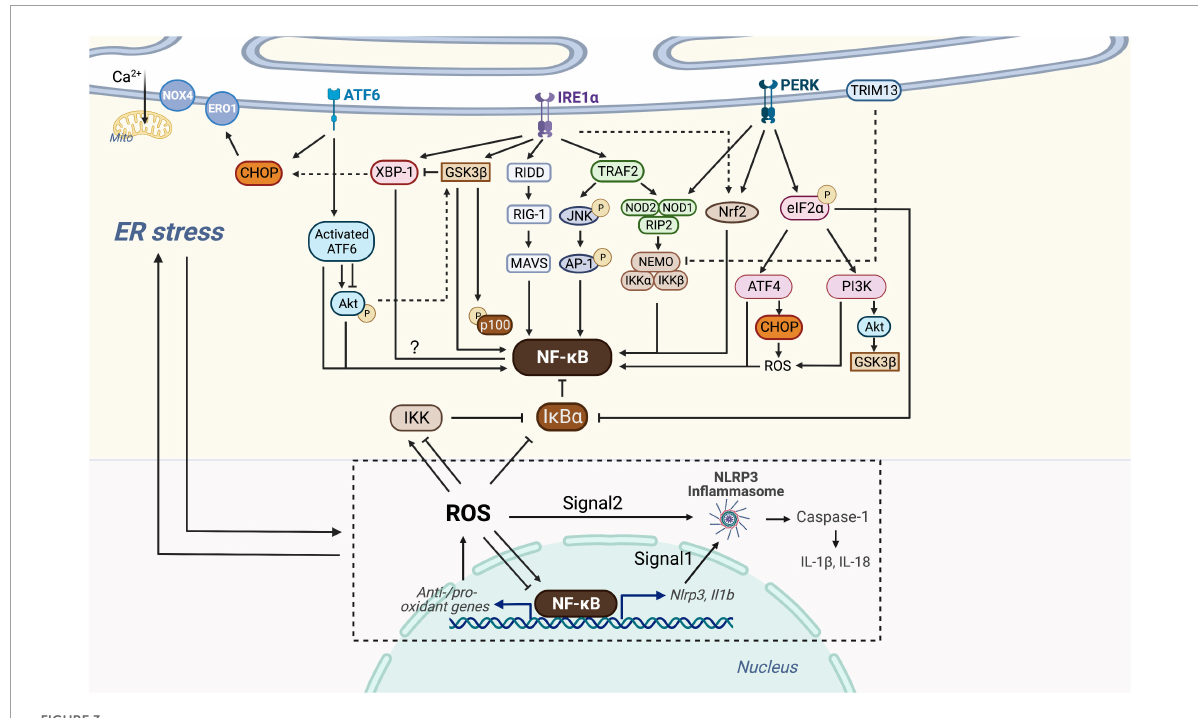
FIGURE3 Crosstalk of NF- κ B and ER stress. Three branches of UPR (IRE1 α , PERK, and ATF6) of ER stress are able to intersect with NF- κ B. Activated IRE1 α recruits TRAF2, which activates JNK and then AP-1 or associates with IKK probably via NOD1/2 and RIP2. IRE1 α is also linked with the RIDD/RIG-I/MAVS pathway and GSK3 β to activate NF- κ B. IRE1 α oligomerization increases XBP-1 expression which might be associated with decreased NF- κ B expression, but GSK3 β activation inhibits IRE1 α -dependent XBP-1 splicing. PERK branch can induce NF- κ B